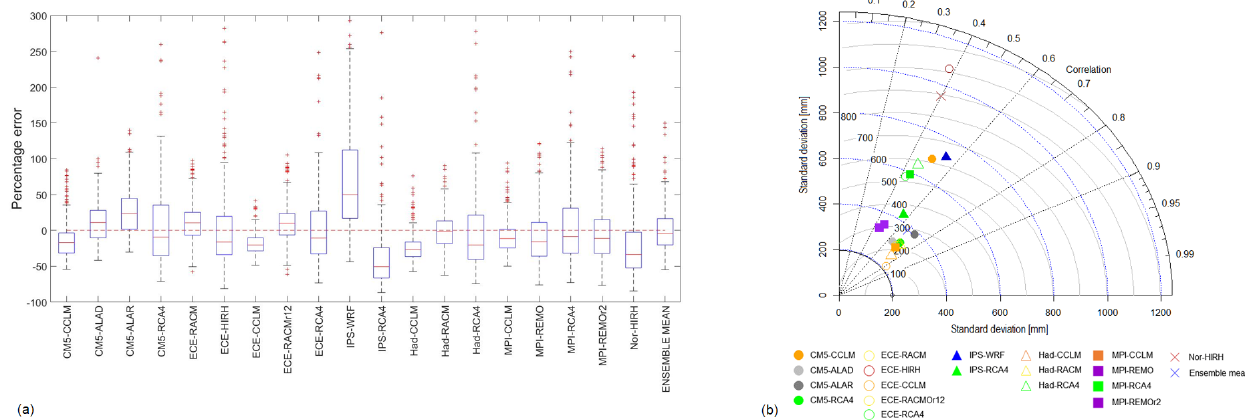
relative errors for some models is less than 20 %; however, many models have a large dispersion with error values over 100 %. The CM with the highest positive error is IPS-WRF, while the ones with the highest negative errors are the IPS- RCA4 and Nor-HIRH models. The GCM–RCM combina- tions with the smallest IQR of errors are those using CCLM RCMs. The model with the smallest bias is Had-RACM.